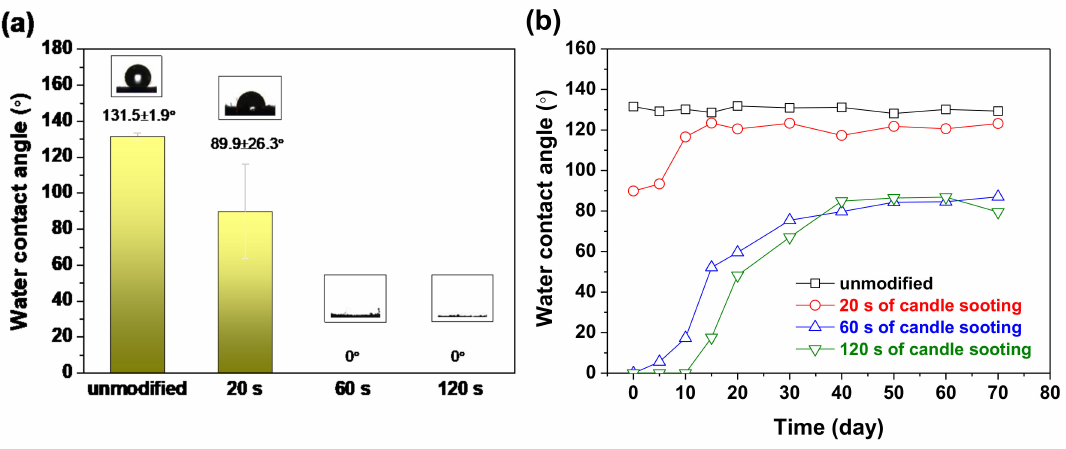
Figure 4. ( a ) Water contact angles of the unmodified carbon cloth and those modified by candle sooting for 20, 60, and 120 s. ( b ) Water contact angles of the unmodified and candle-soot-modified carbon cloths as a function of the standing